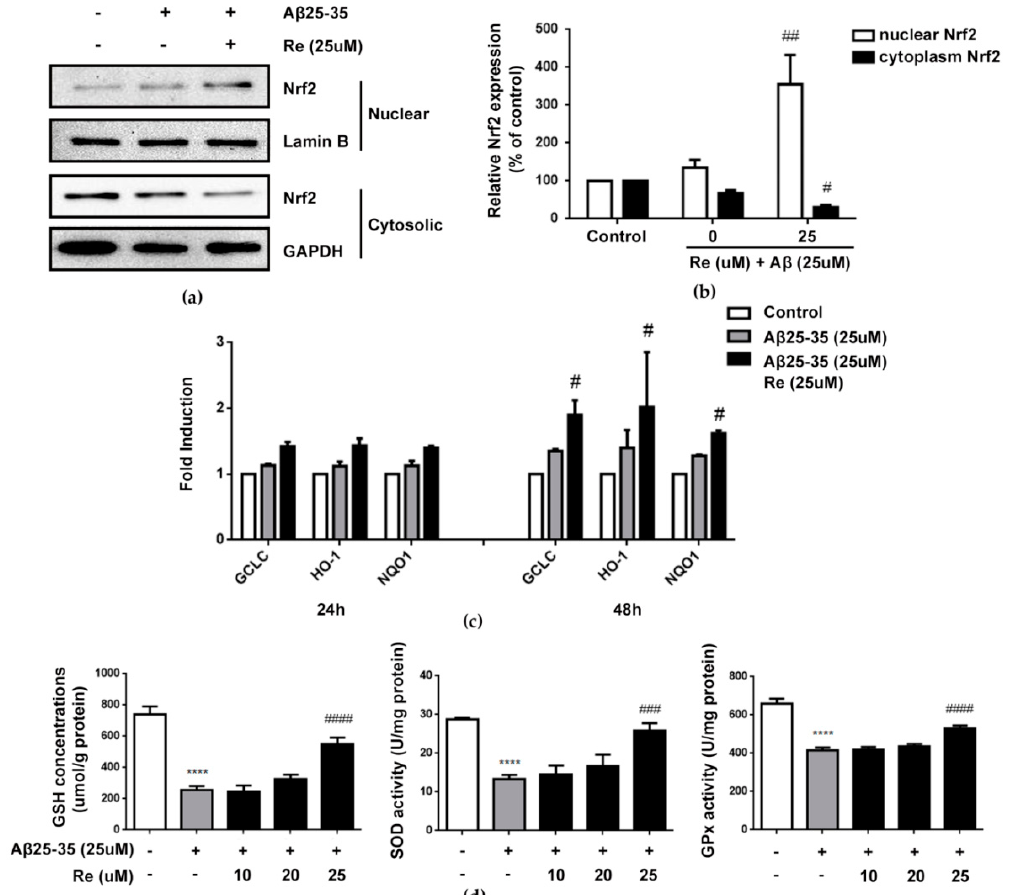
Figure 5. Ginsenoside Re induced the activation of Nrf2-antioxidant signaling in A β -induced SH-SY5Y cells. ( a , b ) Ginsenoside Re promoted the nuclear translocation of Nrf2 in A β -induced SH-SY5Y cells by western blot assay; ( c ) A β treatment significantly induced the expression of Nrf2-mediated antioxidant response genes, including GCLc , NQO1 and HO-1 at both 24 h and 48 h. Ginsenoside Re treatment potentiated this increase at both time points than A β induced alone ( n = 3 per treatment condition); ( d ) the concentrations of GSH and activities of SOD and GPx in SH-SY5Y cells in di ff erent treatments were measured as described in the materials and methods ( n = 5 per treatment condition). **** p < 0.0001 versus control; # p < 0.05, ## p < 0.01, ### p < 0.001, #### p < 0.0001 versus A β treatment